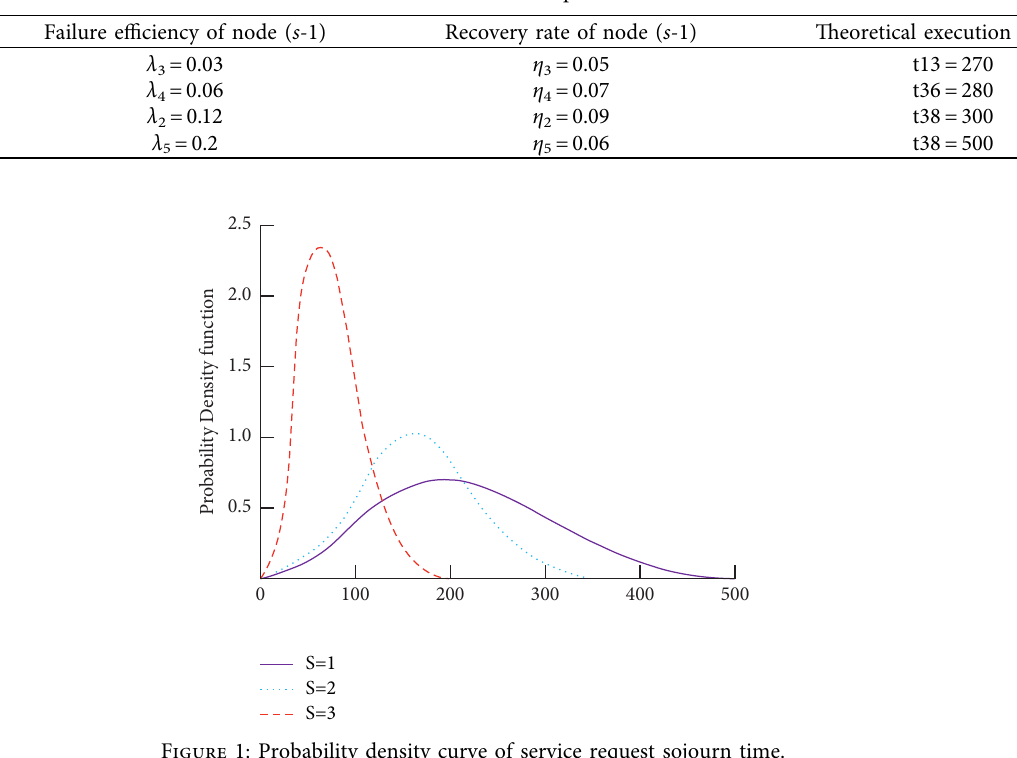
Table 2: Communication link parameters.